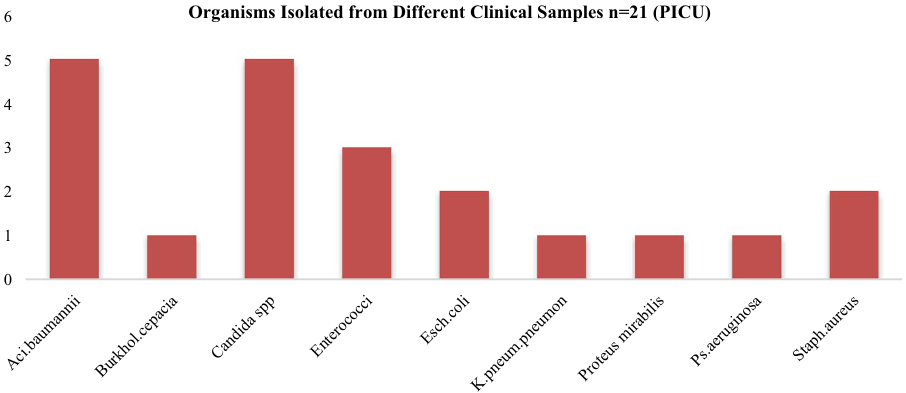
Figure 12. Spectrum of microorganisms isolated from clinical sample: Blood sample from PICU Isolates of blood specimen from clinical samples shows the presence of Acinetobacter. Baumanii (5/21) and candida spp. (5/21) in equal numbers followed by Enterococci (3/21), E.coli (2/21), Staphylococcus aureus (2/21), Burkholderia cepacia (1/21), K. pneumoniae. Pneumonia (1/21), Proteus mirabilis (1/21), Pseudomonas aeruginosa